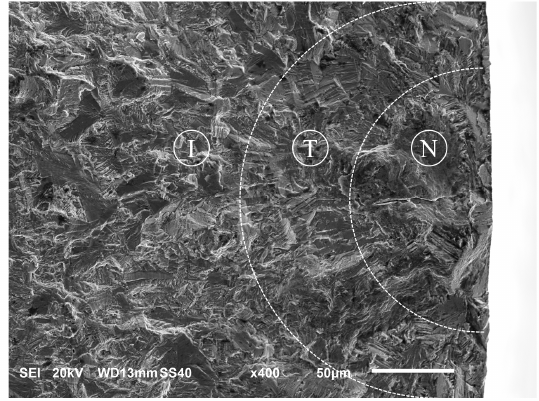
Figure 12. SEM micrograph of aged Inconel 718 ( R = − 1, f = 20 kHz, σ a = 540 MPa, N f = 1.57 ∗ 10 9